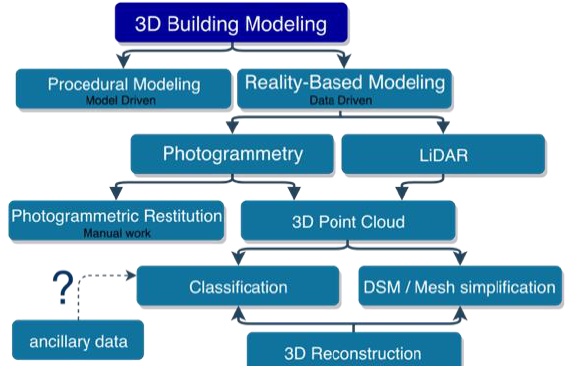
Figure 2. State-of-the-art 3D building reconstruction approaches.